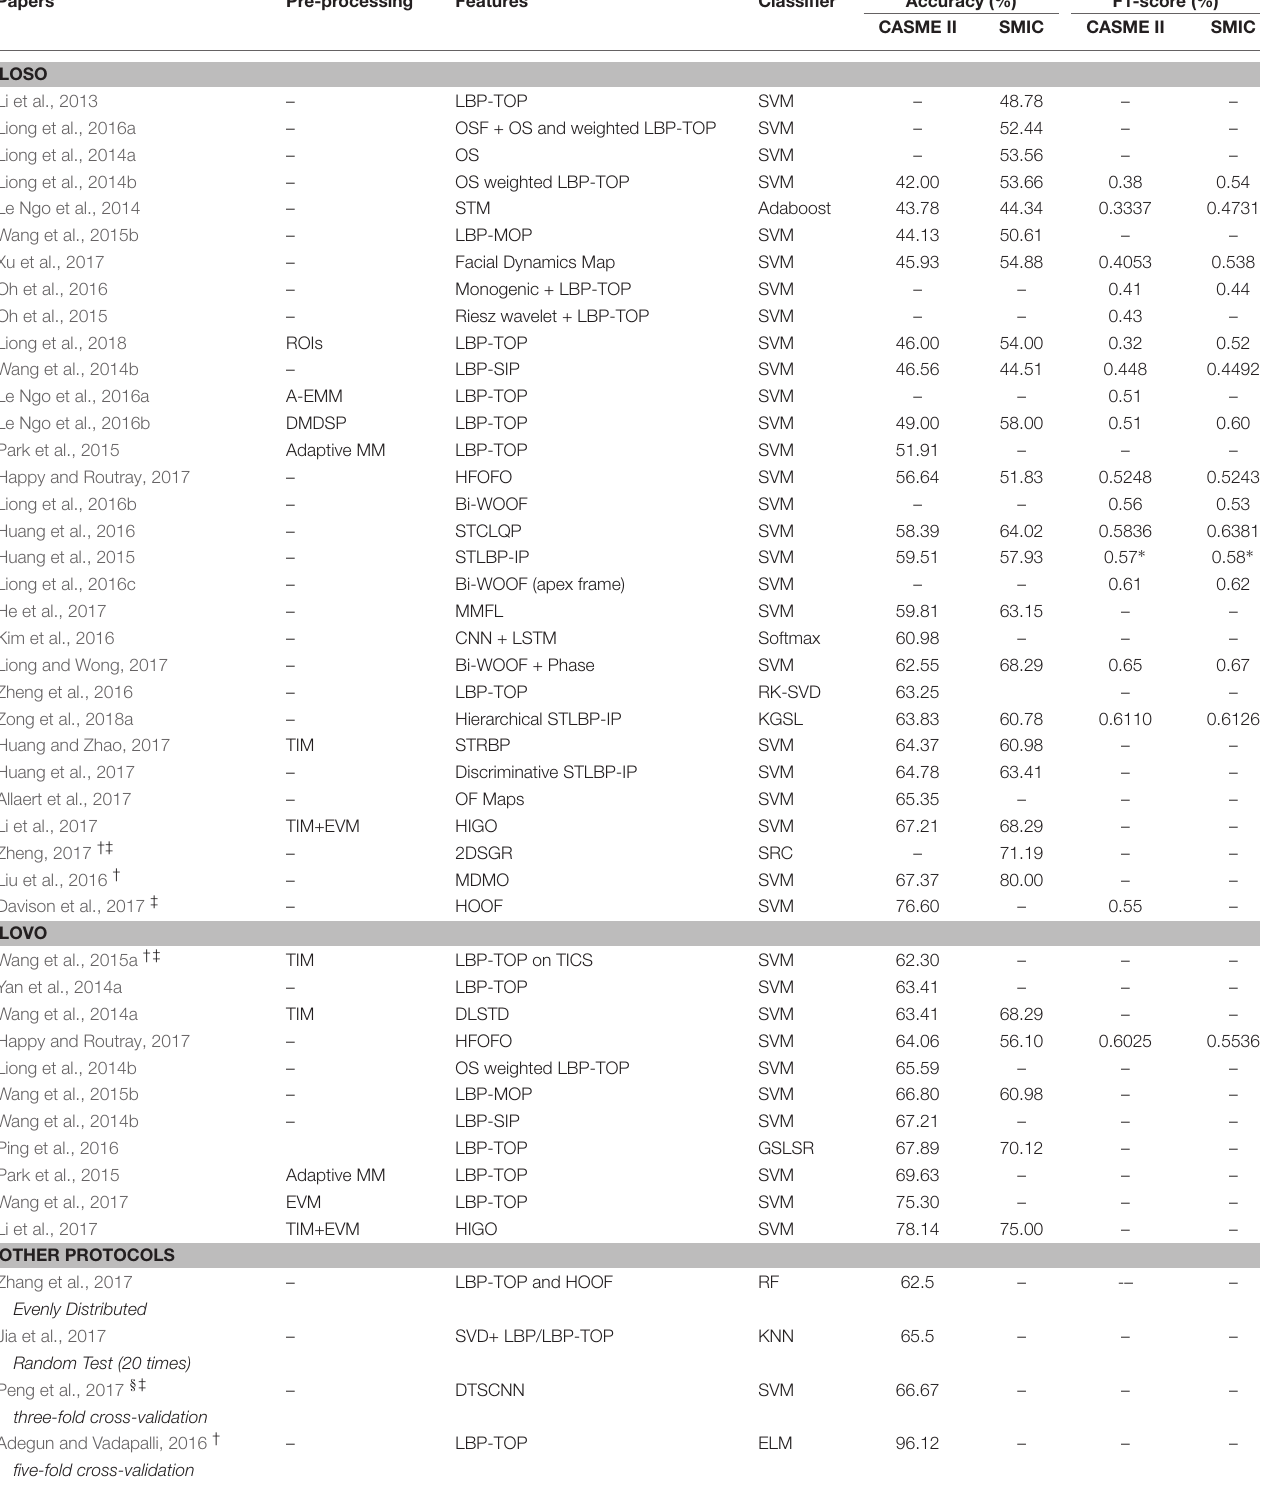
TABLE 4 | Benchmarking facial micro-expression recognition works in